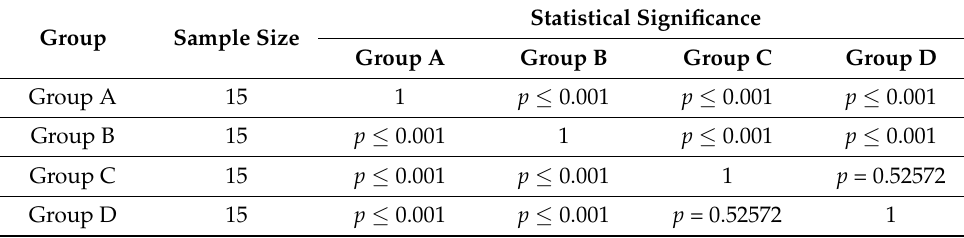
Table 3. Comparison of mean shear bond strength between the treatment and control group. Group Sample Size